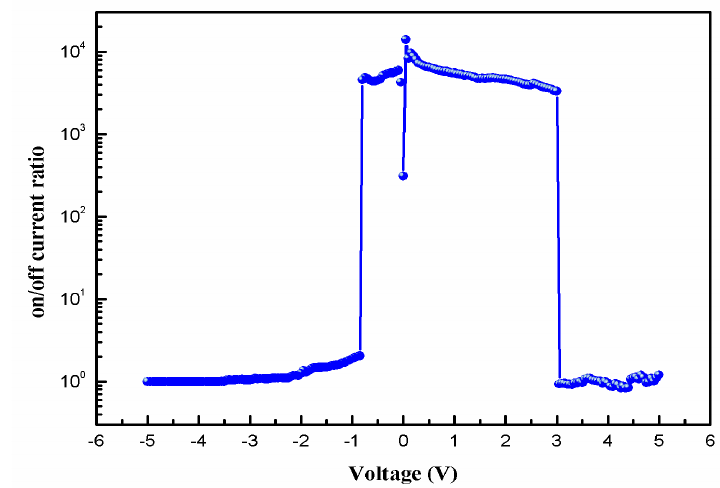
Figure 4. Variation in the on/off current ratio of Al/ Bombyx mori body fluid film/ITO biomemristor with the applied voltage.